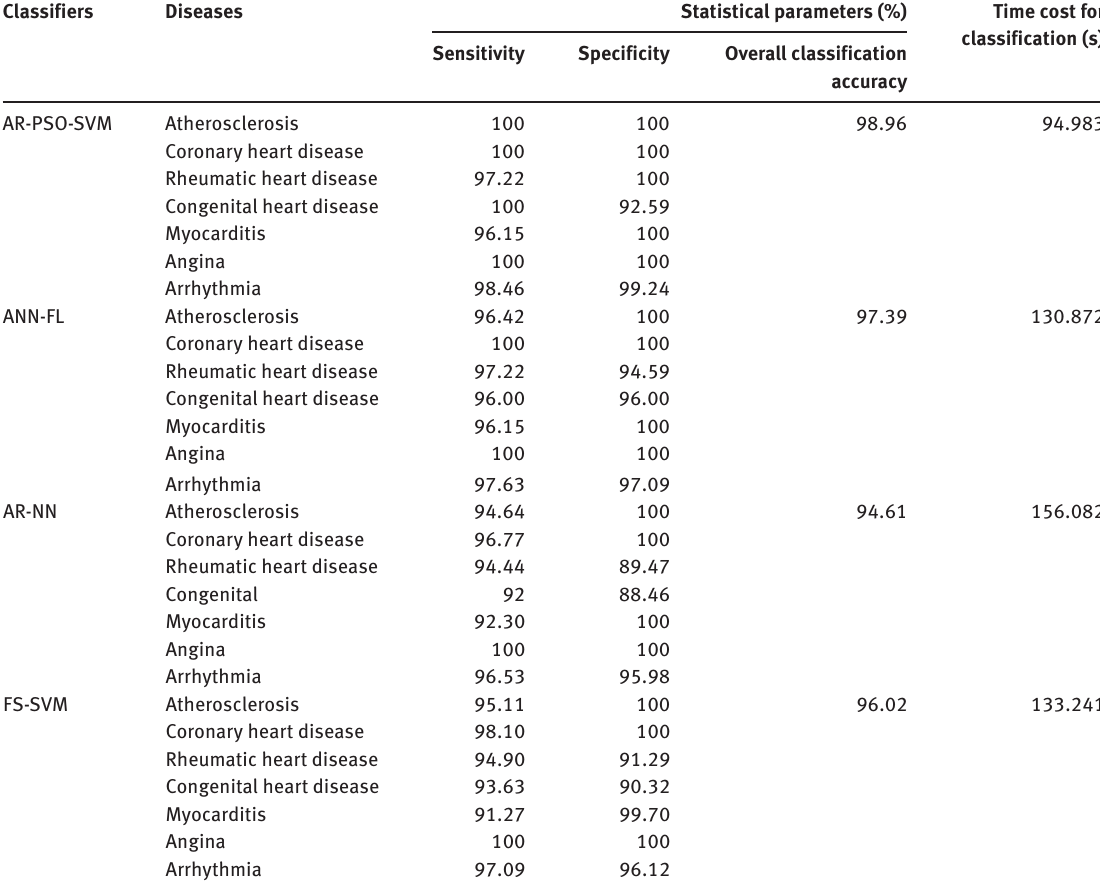
Table 4: Statistical Parameters of Each Classifier.